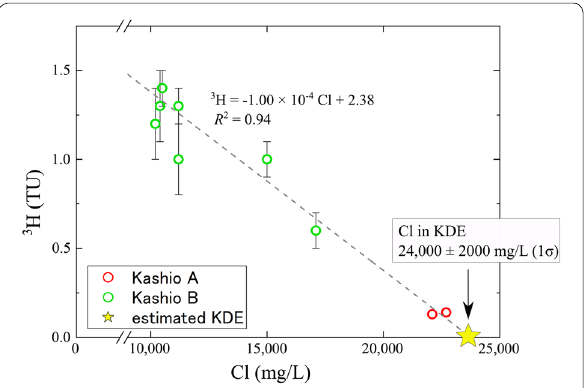
Fig. 6 Negative linear relationship between 3 H and Cl concentrations in the Kashio A and B water samples. Assuming that KDE has no 3 H, the Cl concentration of KDE was estimated to be 24,000 [ R 2 correlation